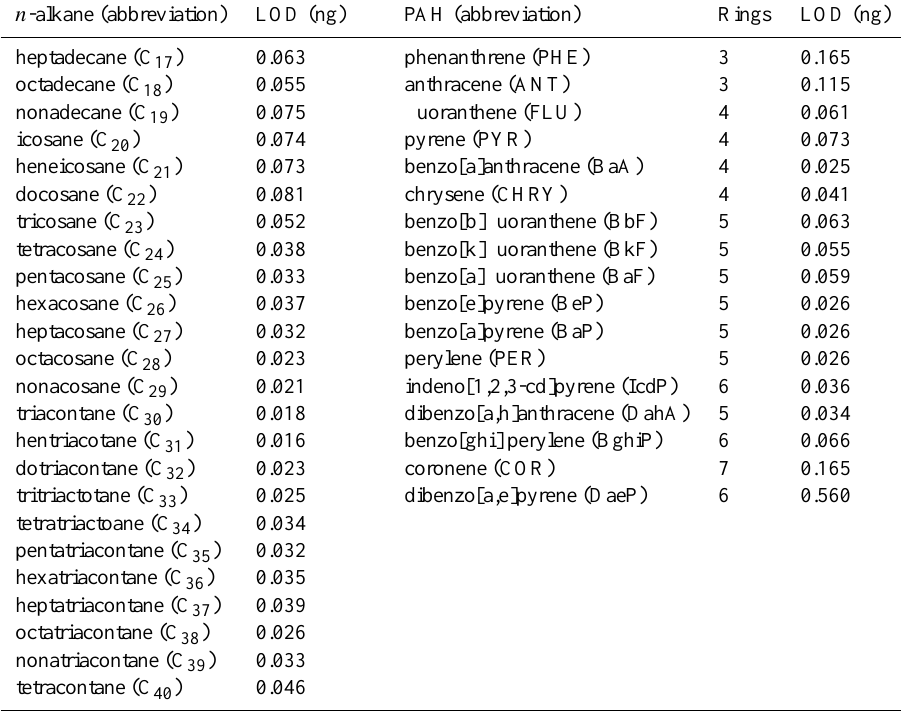
Table 1. Limits of detection (LODs) for the measured species in this study. n -alkane (abbreviation)